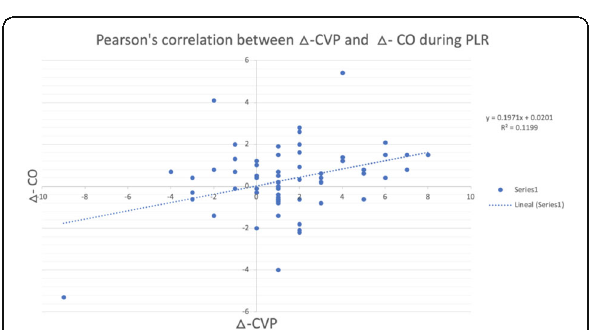
Fig. 3 (abstract 001294). See text for